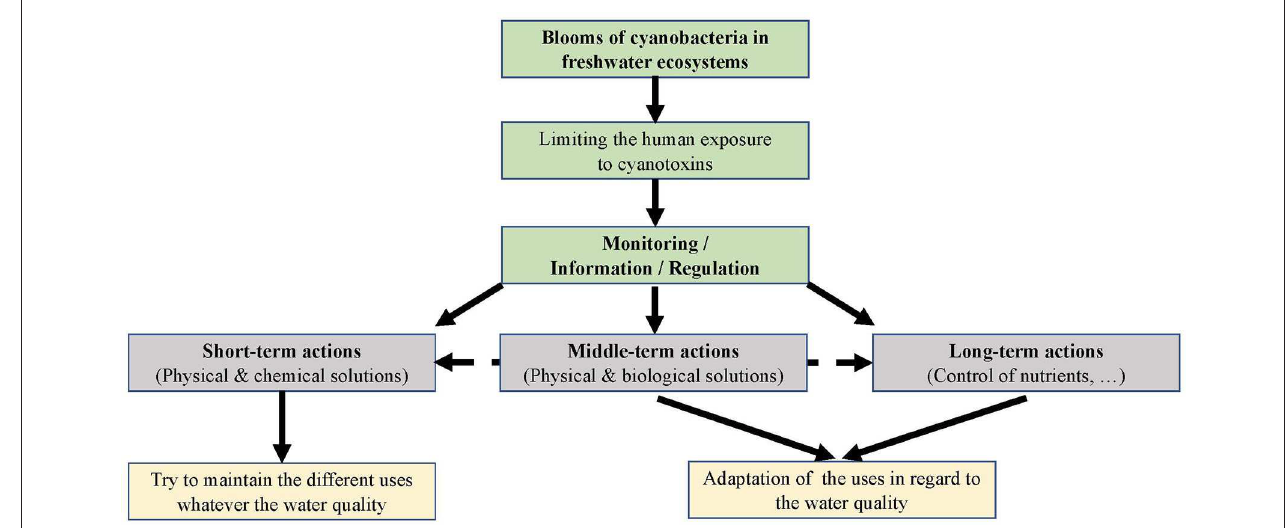
FIGURE 1 | Management scheme for cyanobacterial